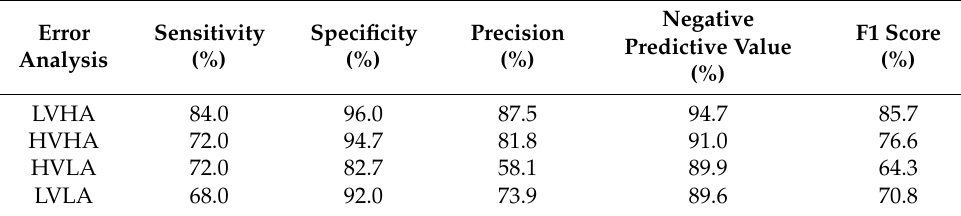
Table 11. The error analysis on frontal electrodes for results on differential average ERPs.